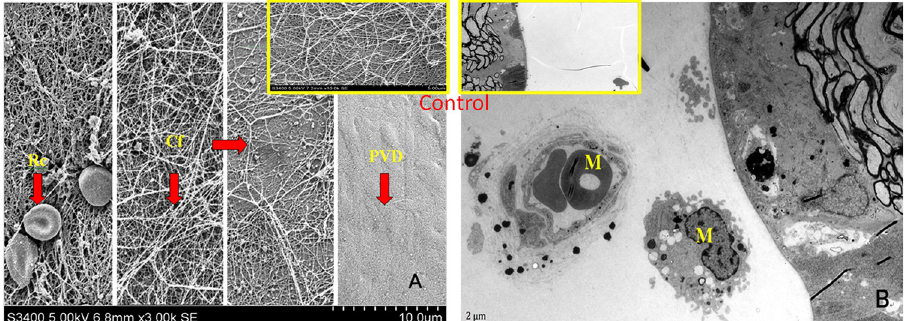
Fig 3. Ultrastructure of vitreoretinal interface. (Study eye: A. SEM × 3000, B. TEM × 4000; Control eye). Rc: red blood cells were interwoven with collagen fibers. Cf: the collagen fibers were distributed sparsely. PVD: VRI was damaged irregularly, vitreous cortex peeled from the ILM of retina. M: macrophages attached to the VRI and induced PVD.